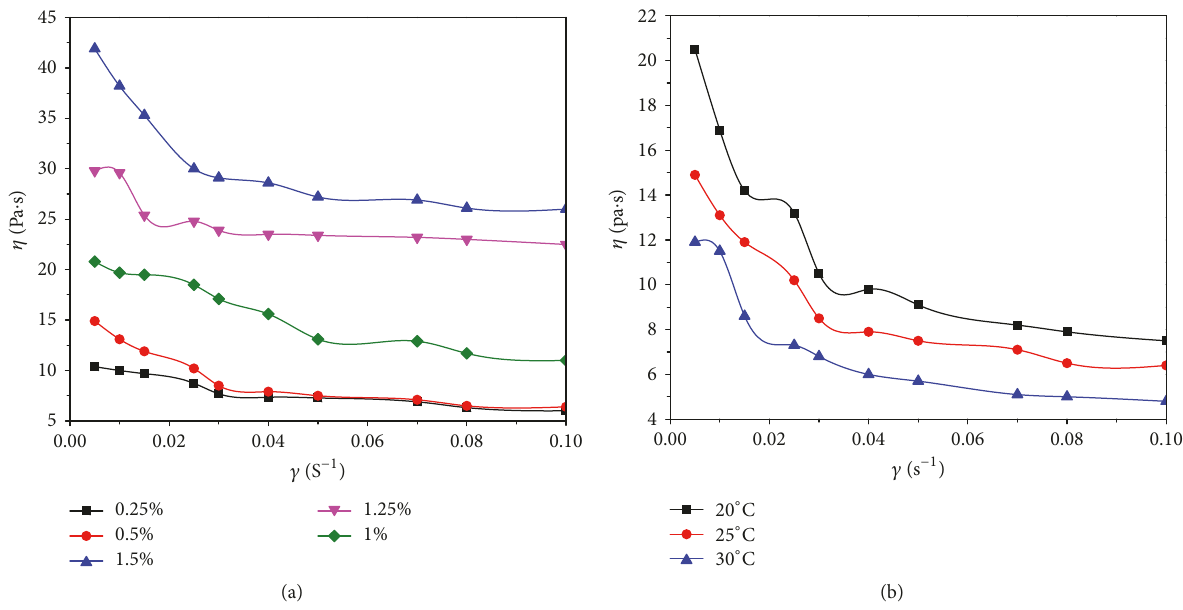
Figure 1: Effect of (a) cellulose concentration and (b) temperature on the apparent viscosity of the solution. 𝛾 is the mass fraction of BC in the BC